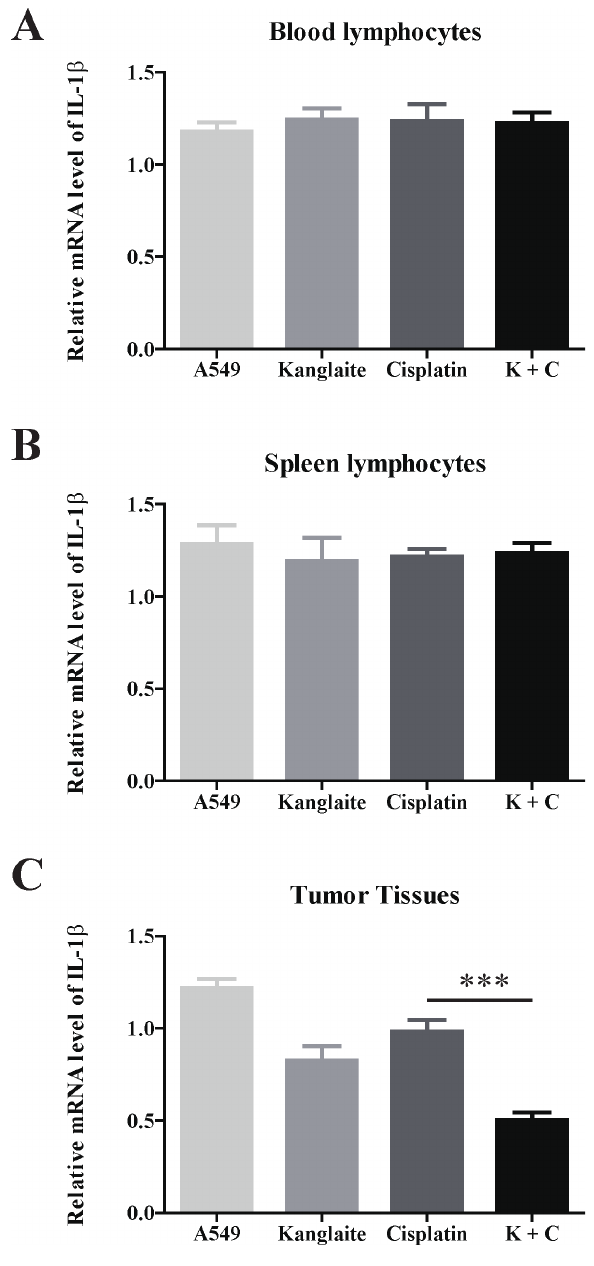
Fig. 5. Kanglaite reduced the IL-1 β expression in A549 cells in vivo. The relative expression level of IL-1 β in blood lymphocytes (A), spleen lymphocytes (B), and tumor tissue (C) was detected by real-time PCR. Data shown as mean with SEM ( n = 5) and *** P <